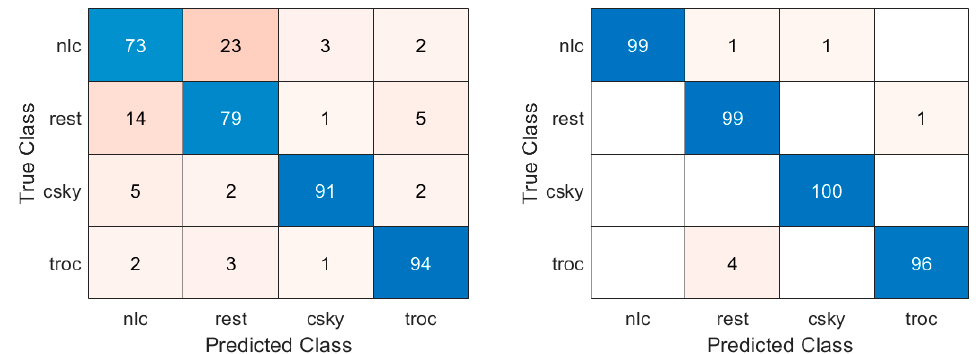
Figure 10. Confusion matrices for the four categories using a histogram of oriented gradients (HOG) (on the left) and when using the proposed CNN based approach (on the right).